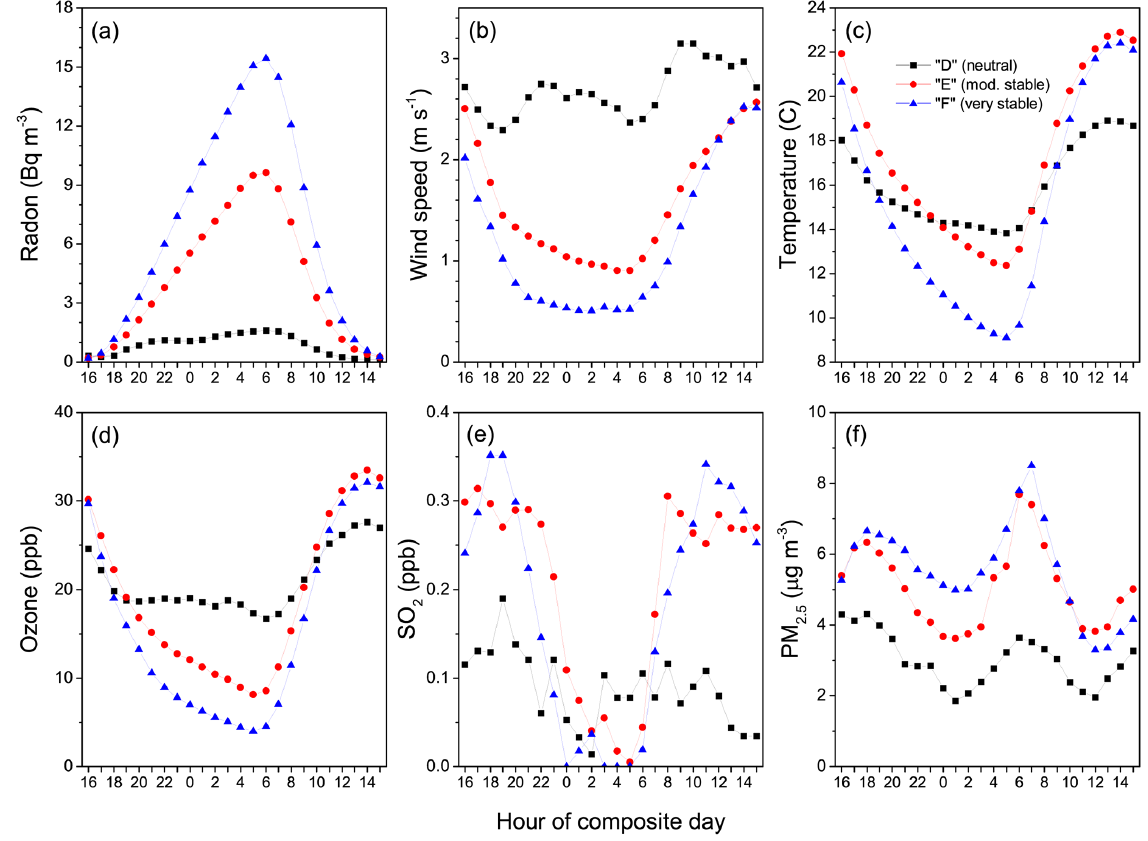
Figure 10. Mean hourly diurnal composite plots of selected climatological and pollution quantities for whole days categorised by their dominant nocturnal Pasquill–Gifford stability category: D – neutral; E – weakly stable; F – moderately stable.